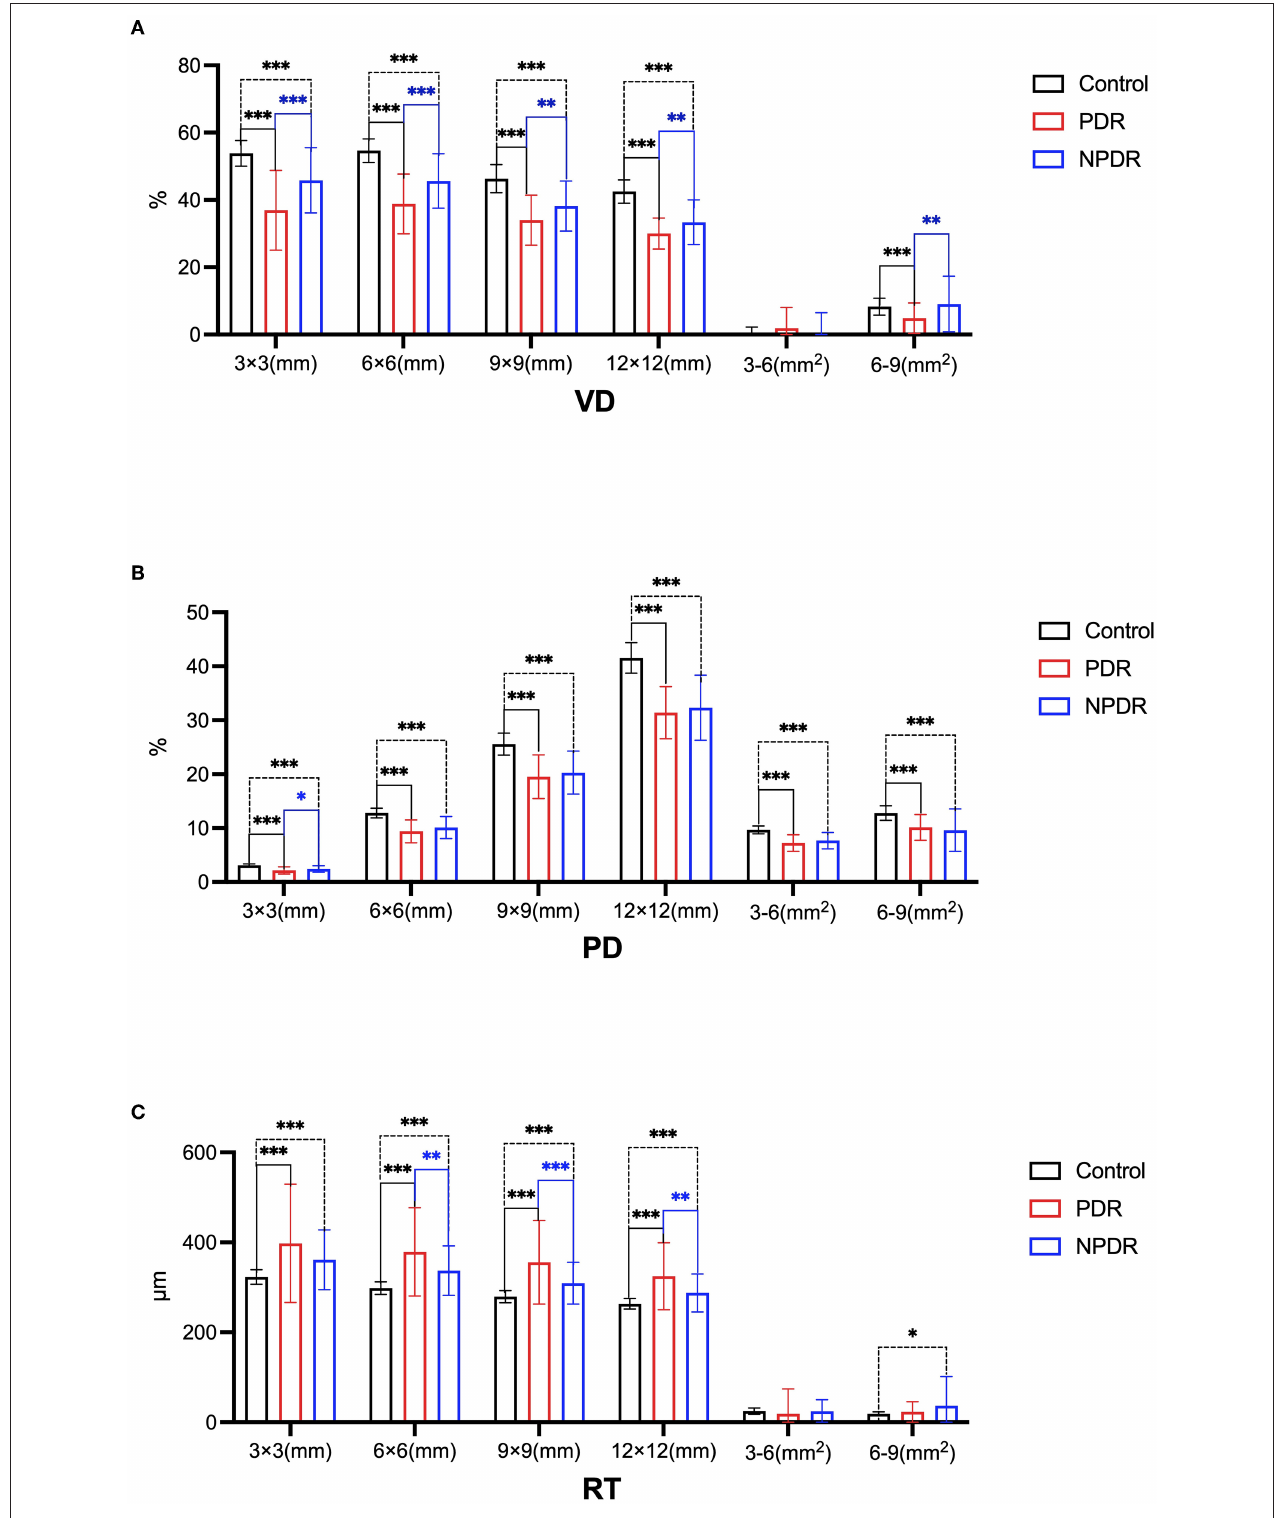
FIGURE 1 | The changes of the deep vascular complex in healthy control group, PDR group and NPDR group by SS-OCTA (* p ≤ 0.05, there is a statistical difference.** p ≤ 0.01, *** p ≤ 0.001, there is a significant difference). (A) Comparison of VD in 3 × 3 (mm), 6 × 6 (mm), 9 × 9 (mm), 12 × 12 (mm), 3–6 (mm 2